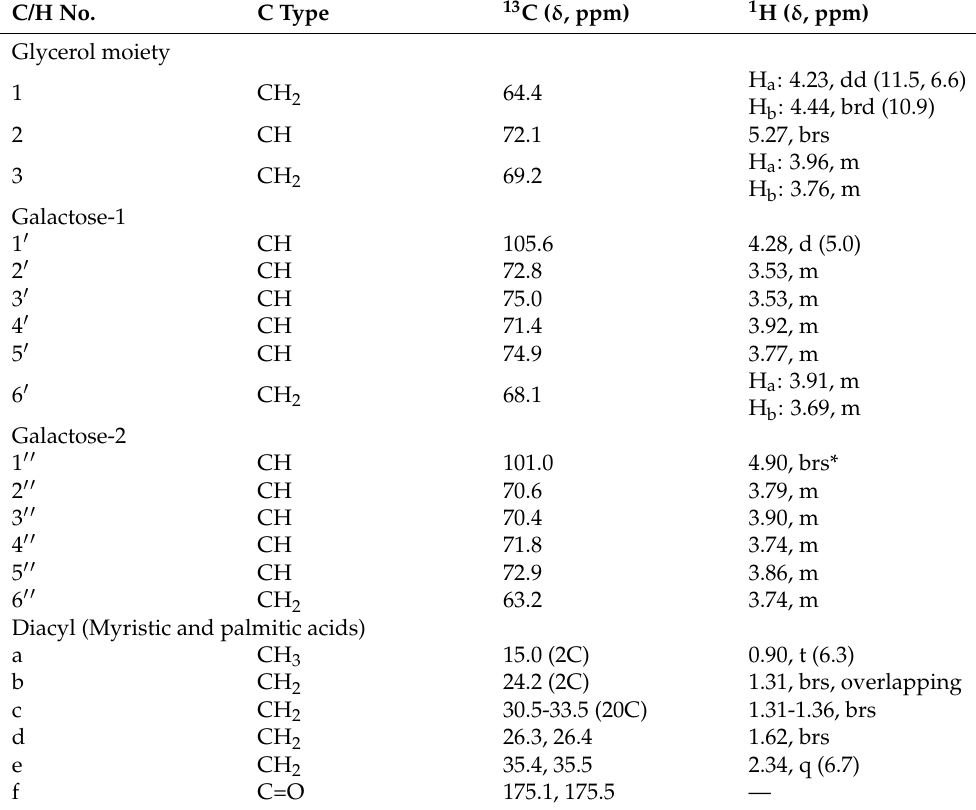
(Figure 2). The appearance of H-1 (cid:48) as a doublet ( J = 5.0 Hz) at δ H 4.28 indicated that the galactosyl linkage with the sn -3 position of glycerol is in the β -configuration. However, due to the coincidence of the anomeric proton signal of the second galactose moiety (H-1 (cid:48)(cid:48) ) with the solvent signal at δ H 4.90 (Figure 3c), the 1 H NMR experiment was repeated using DMSO- d 6 as a solvent (Figure 3d), which revealed a broad singlet at δ H 4.69 corresponding to H-1 (cid:48)(cid:48) , confirming an α -linkage between the two galactose moieties. The connectivity of the different moieties was established by using the HMBC spectrum (Figure S16). The most important HMBC correlations were found between the proton signals at δ H 5.27 (H-2), 4.44 (H b -1), and 4.23 (Ha-1) with the carbonyl ester groups at δ C 175.1/175.5 (C-f). Table 2. 1 H (500 MHz, CD 3 OD) and 13 C (125 MHz, CD 3 OD) NMR spectral data of compound 2 ( J in Hz). C/H